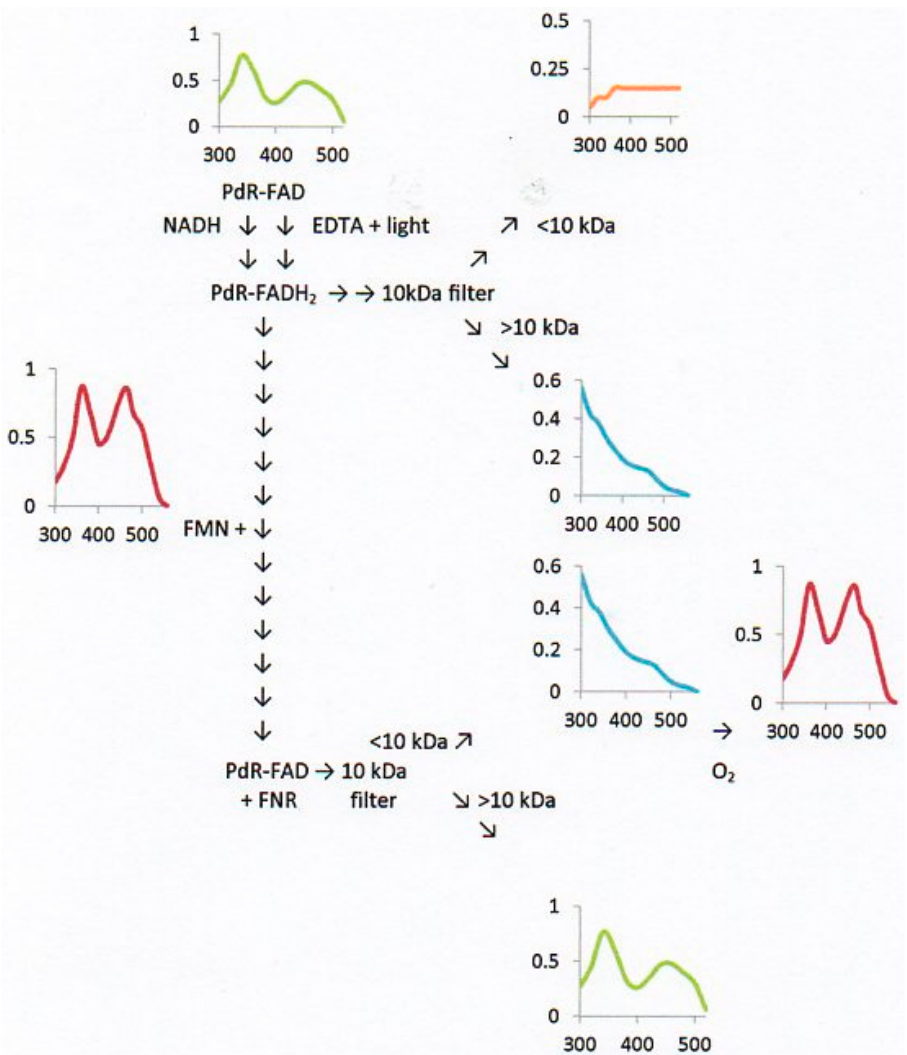
Figure 4. Initial transfer of reducing power from NADH to the bound flavin in putidaredoxin reductase (PdR) to form PdR-FADH 2 , and subsequent transfer from PdR-FADH 2 to unbound FMN to form FNR. An equivalent redox transfer yielded freely diffusible FNR from PdR-FADH 2 generated by prior photoreduction.